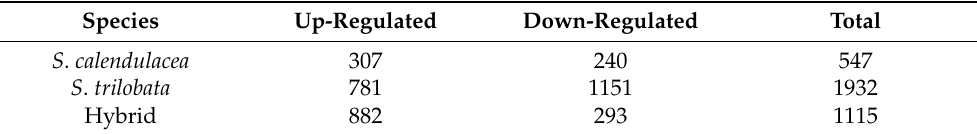
Table 1. DEGs under normal irrigation and drought treatment of three